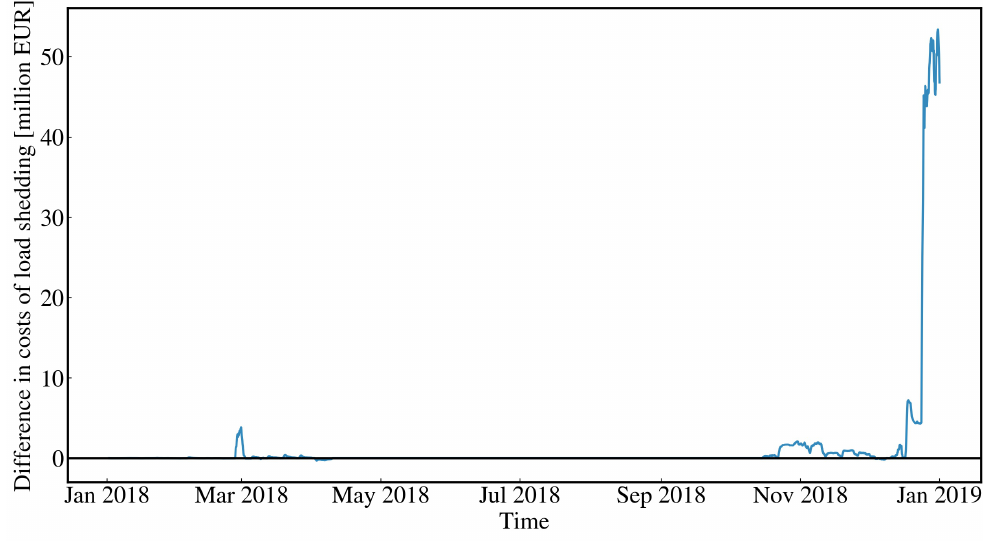
Figure 6. Difference in load shedding costs between SOC _ HEUR ( 1000,0 ) and SOC _ HEUR ( 1000,1000 ) . Displayed is the difference in costs of load shedding in million EUR. Displayed is the daily rolling average of the cost time